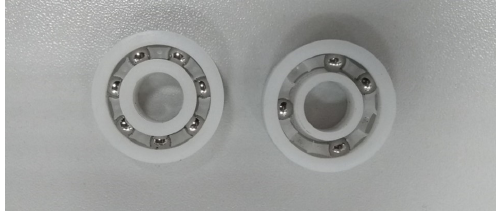
Figure 7. Normal and faulty